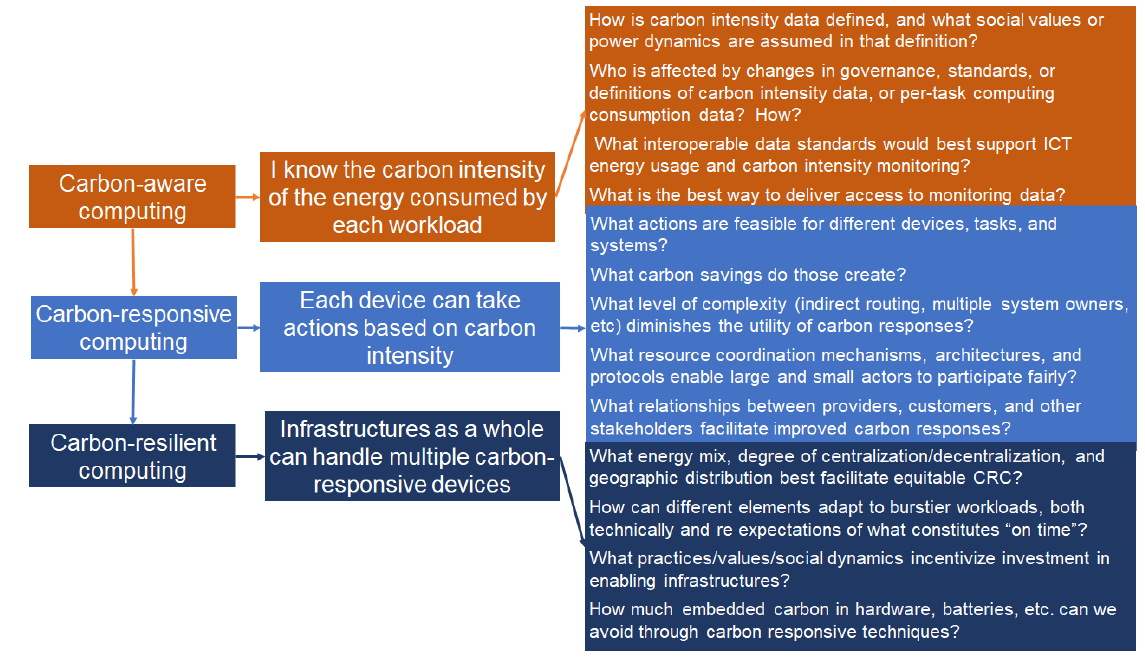
Figure 2. Three stages of carbon-responsive computing. Each phase, represented as a different shade of color, highlights key questions that need to be addressed when working at that phase. By examining the other phases, one can better anticipate the consequence for other stages.